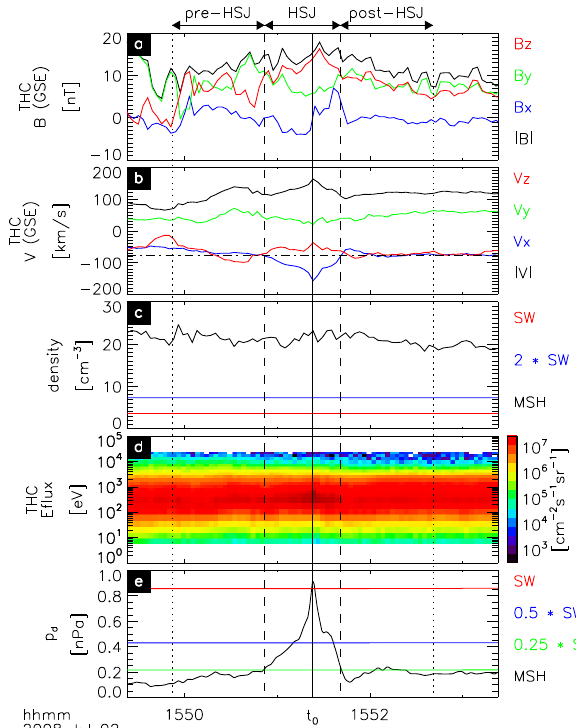
Fig. 1. A high-speed jet observed by THC on 2 July 2008 illus- trating the selection criteria. From top to bottom, (panels a to e ): magnetic and ion velocity measurements in GSE, ion density, ion energy flux density, and dynamic pressures. (c) shows THC mag- netosheath (MSH) measurements in black, and the corresponding OMNI solar wind (SW) ion densities ( n sw and 2 n sw ) are shown in red and blue, respectively. (e) depicts GSE x component dynamic pressure ( p d , msh ,x ) at THC in black; corresponding solar wind data ( p d , sw , p d , sw / 2, and p d , sw / 4) are shown in red, blue, and